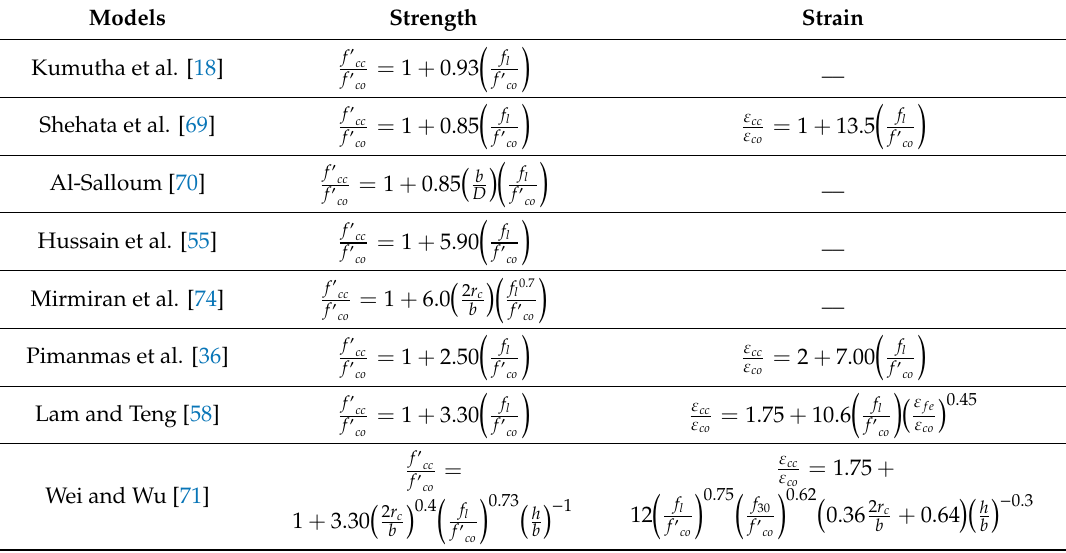
Table 9. Existing strength and strain models for FRP-confined square